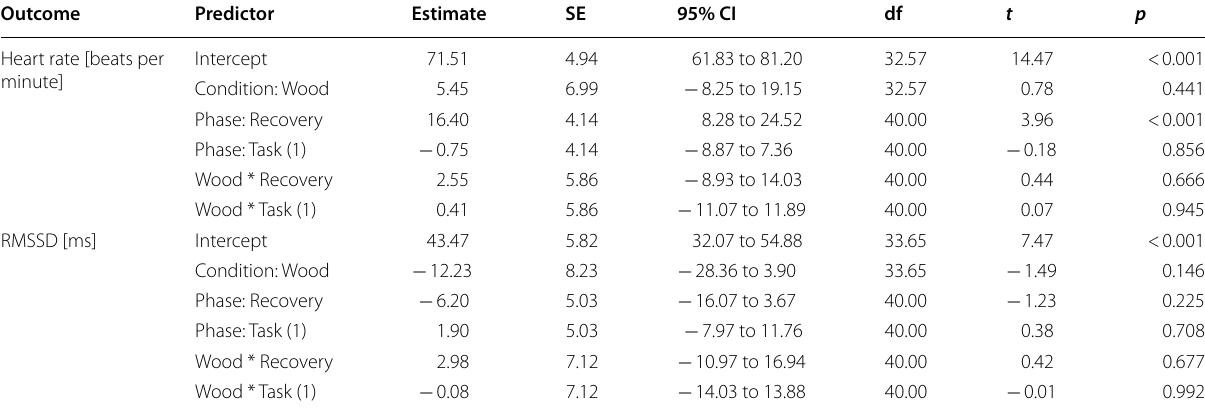
Significant predictors ( p < 0.05) are shown in bold